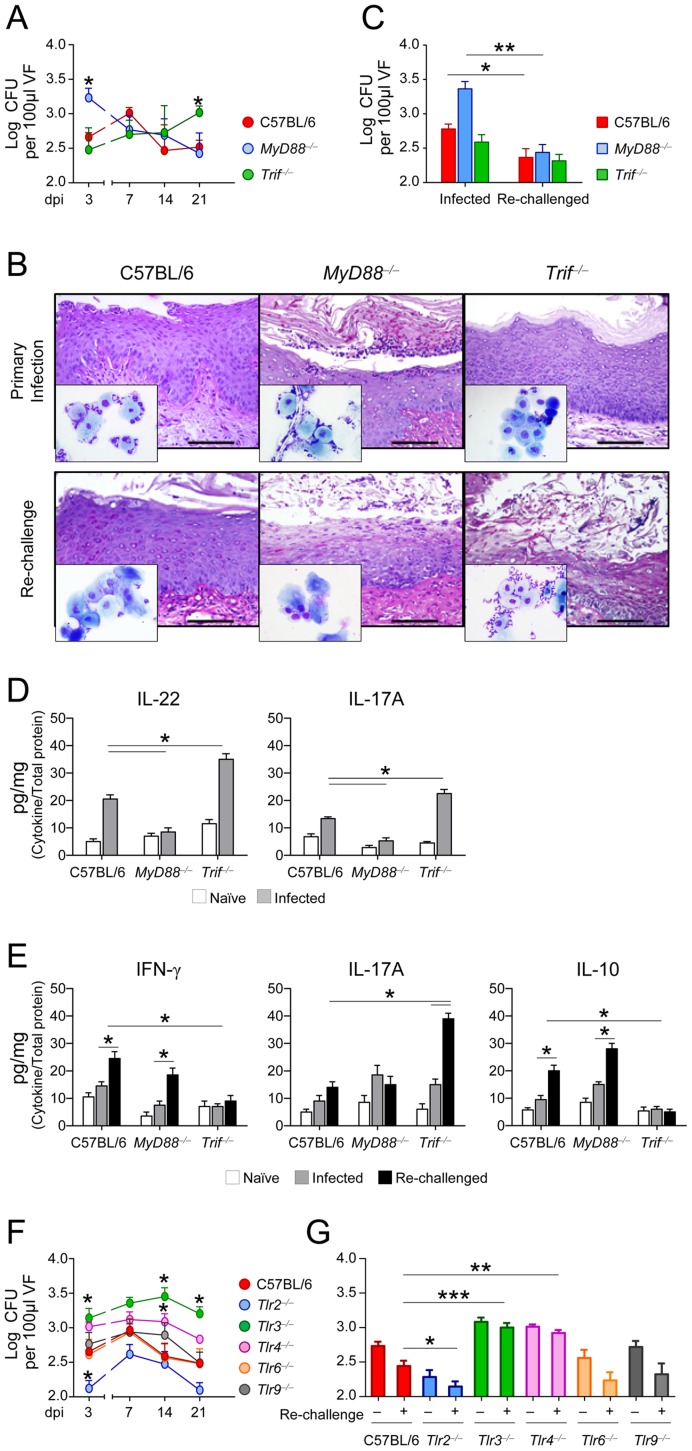
Immunity and tolerance to VVC occurs through distinct innate recognition receptors.(A) In vivo kinetics of fungal growth in the vagina of C57BL/6, MyD88- or TRIF- deficient mice (n = 6), inoculated intravaginally with 5×106
C. albicans blastospores. Fungal growth was quantified at different dpi and expressed as Log10 CFU/100 µl VF ± s.e.m. Pooled data from 4 experiments. *P<0.05, MyD88- or TRIF-deficient vs. wild-type mice. (B) Periodic acid-Schiff-stained vaginal sections and inflammatory cell recruitment in vaginal fluids (May–Grünwald Giemsa staining in the insets) at 3 days after the primary infection or after re-challenge. Representative images of histology sections and vaginal fluids (out of 4 experiments) were acquired with a 40× and 100× objective respectively. Scale bars, 100 µm. (C) Fungal growth at 3 dpi in mice (n = 6) after the primary infection or re-challenge. Pooled data from 4 experiments. *P<0.05 and **P<0.01, Re-challenged vs. not re-challenged (infected) mice. (D) Cytokine levels (pg/mg, cytokine/total proteins for each sample, at 3 dpi) in the vaginal fluids. Pooled data from 4 experiments.*P<0.05 Knockout vs. C57BL/6 mice. (E) IFN-γ, IL-17A and IL-10 production (pg/mg, cytokine/total proteins) in the vaginal fluids of mice (n = 6) at 3 days after the primary infection (infected) or re-challenge. Pooled data from 4 experiments.*P<0.05, Knockout vs. C57BL/6 mice at 3 days after re-challenge and re-challenged vs. infected mice. (F) Fungal growth in C57BL/6 and TLR-deficient mice (n = 6) at different dpi. Pooled data from 3 experiments. *P<0.05, TLR-deficient vs. wild-type mice. (G) Fungal growth (at 3 dpi) in mice (n = 6) re-challenged 3 weeks after the primary infection. Pooled data from 3 experiments. *P<0.05, WT vs. KO mice.